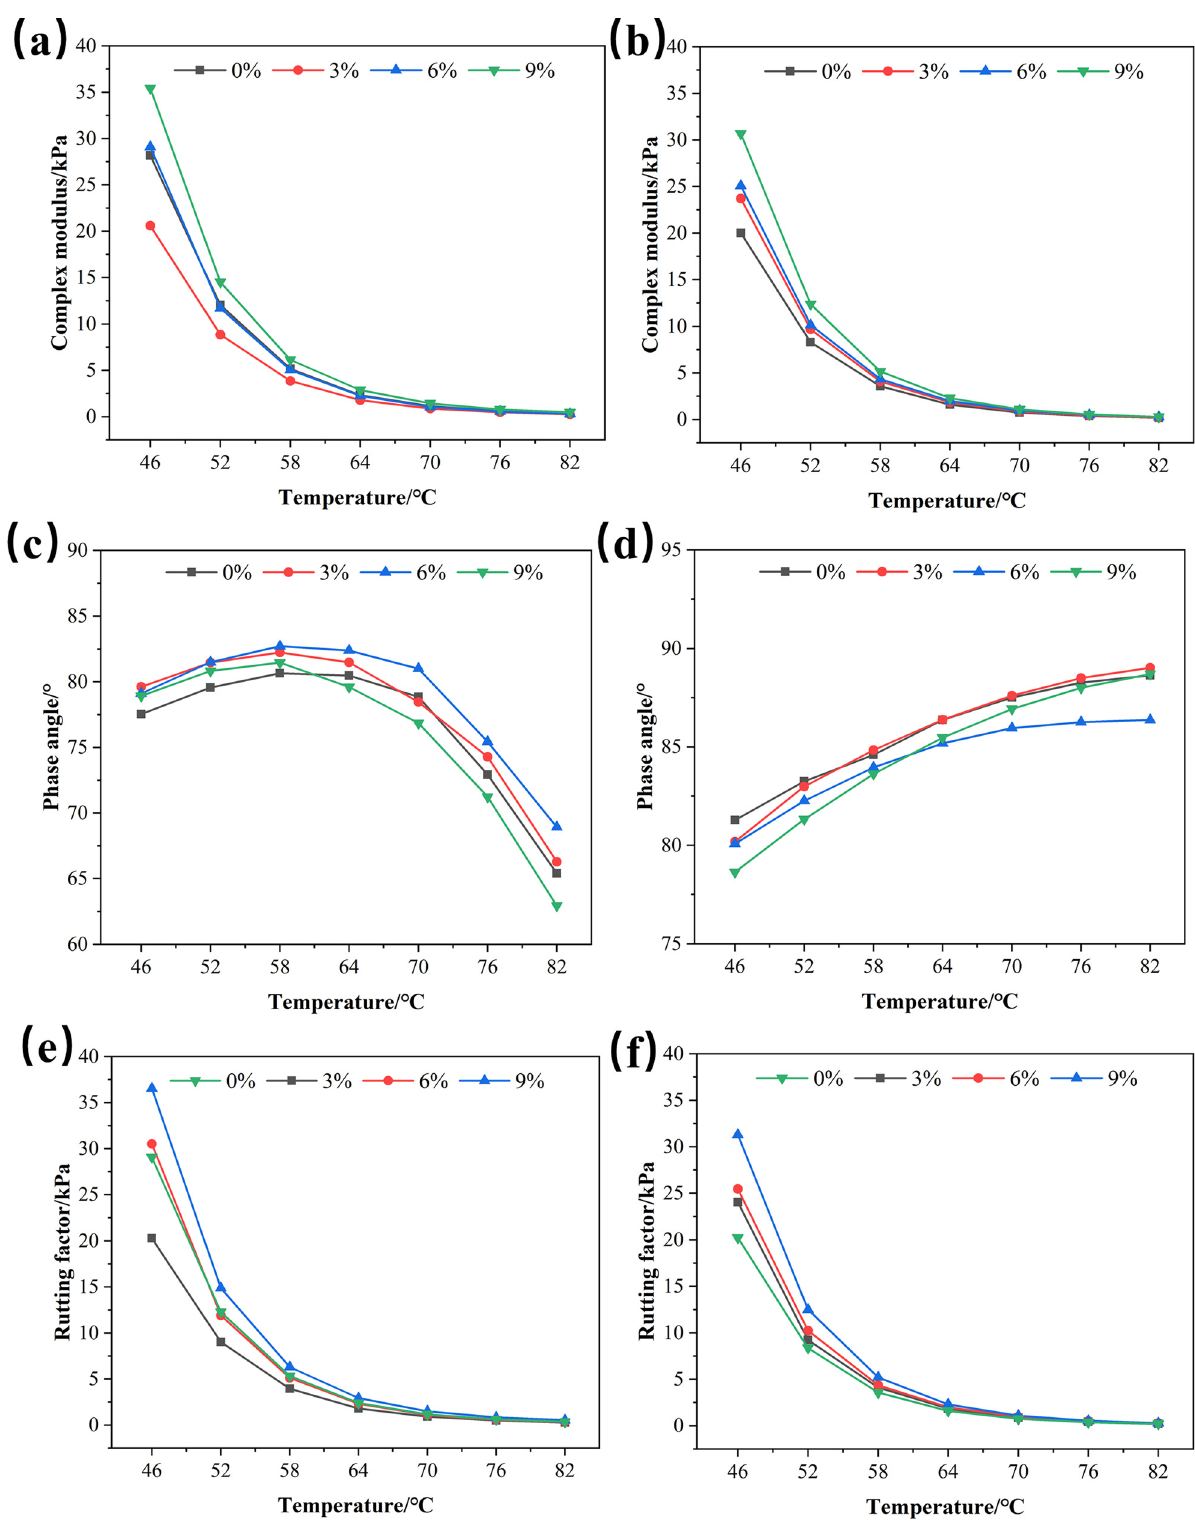
Figure 2: Temperature scanning results under di ff erent parallel plates: ( a ) 8 mm G *, ( b ) 25 mm G *, ( c ) 8 mm δ , ( d ) 25 mm δ , ( e ) 8 mm | G * | /sin δ , and ( f ) 25 mm | G * | /sin δ